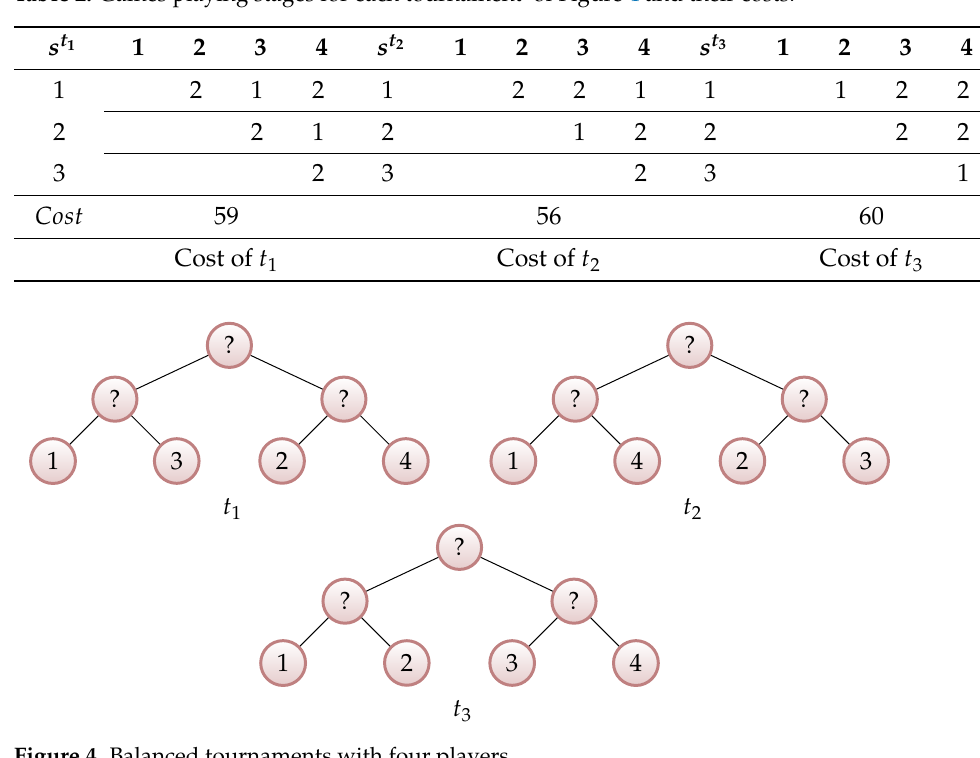
Table 2. Games playing stages for each tournament of Figure 4 and their costs.